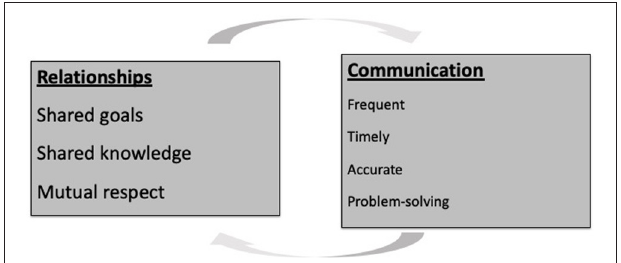
FIGURE 1 | Seven dimensions of relational coordination. Relational Coordination is a mutually reinforcing process of high-quality relationships based on shared goals, shared knowledge and mutual respect and supported by sufficiently frequent, accurate, timely, and problem-solving communication. Source: Gittell